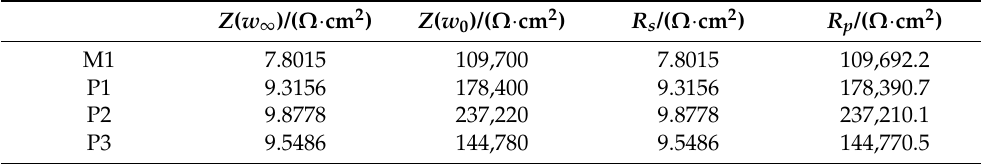
Table 6. Component values of equivalent circuit model.